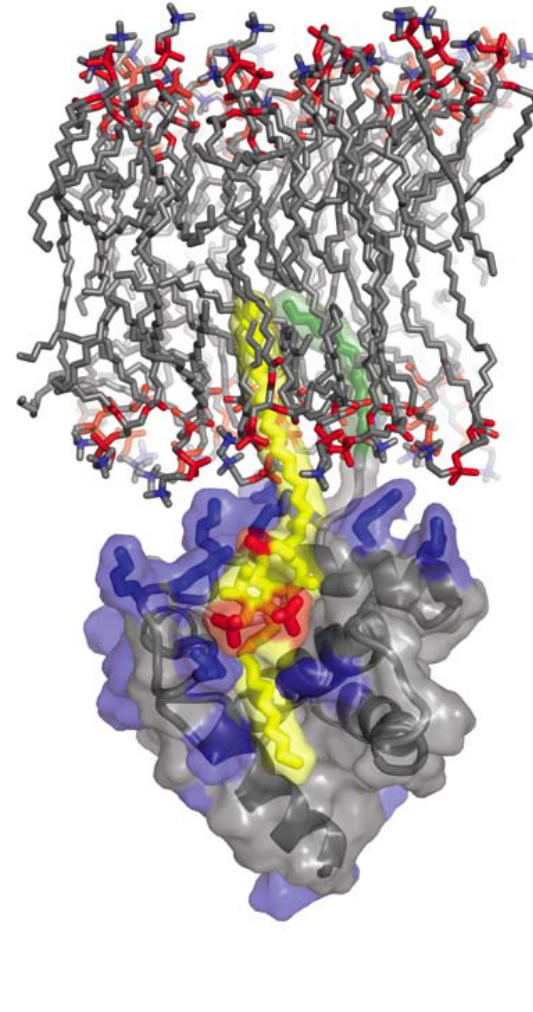
(yellow) binds to the hydrophobic cleft in MA 2